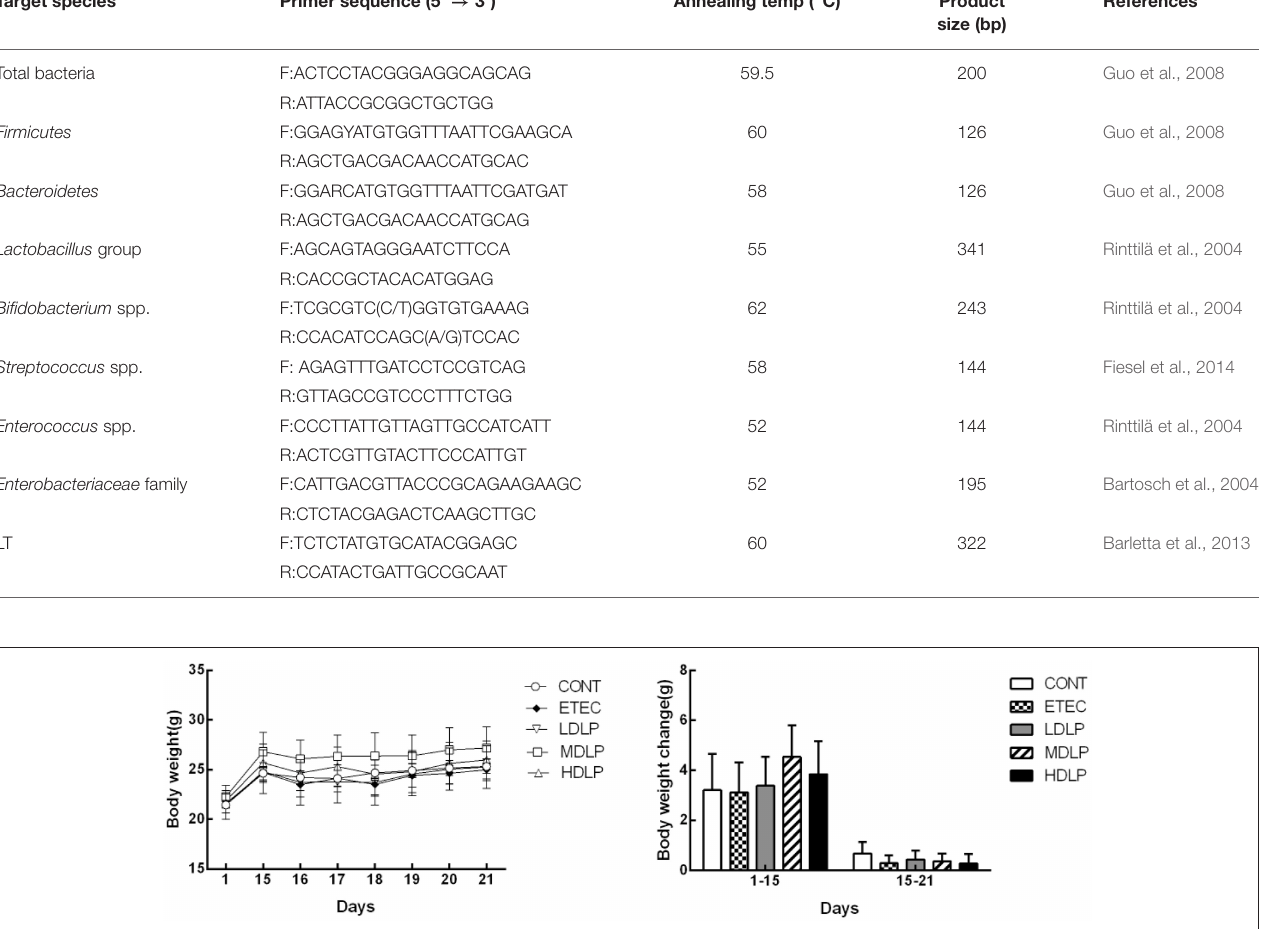
TABLE 2 | Primers used for the absolute quantification of bacterial 16S rDNA copy numbers. Target species